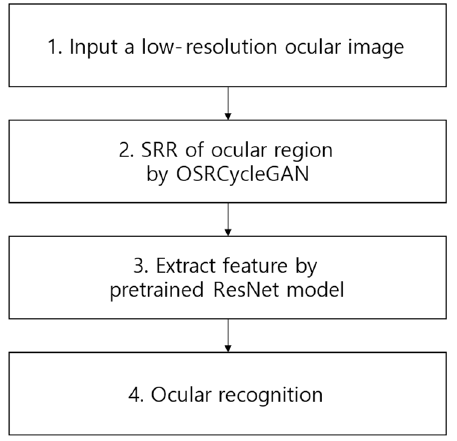
Figure 1. Overview of the proposed method.